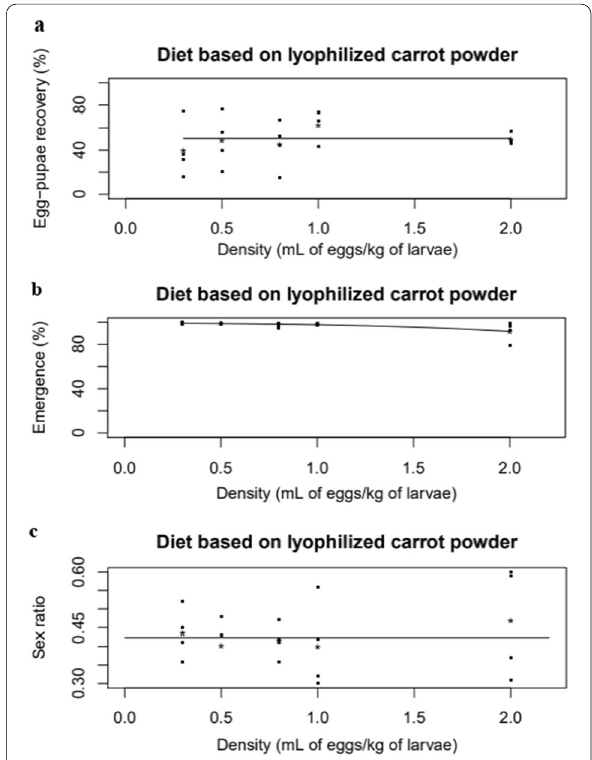
Fig. 3 Larval diet based on lyophilized carrot powder. a Egg-pupae recovery: plot with the fitted curve and observed percentages versus density. b Emergence: plot with the fitted curve and observed percentages versus density. c Sex ratio: plot with the fitted curve and observed proportions versus density